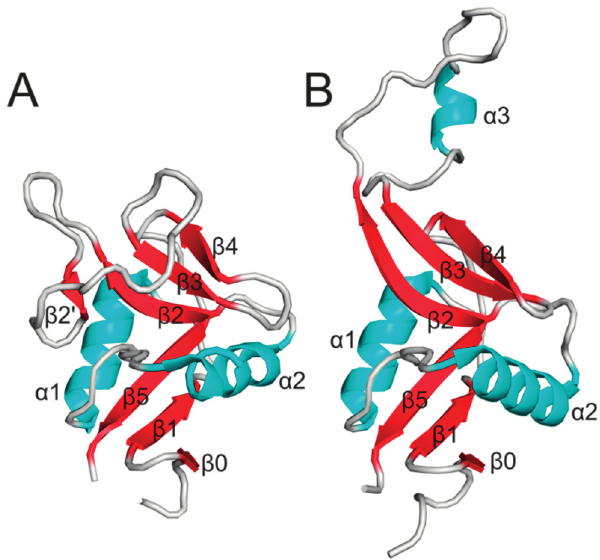
Figure 1. ( A ) Ribbon diagram of a typical CTLD. Secondary structure elements are labeled. α -helices are cyan, β -strands red and loops are gray; ( B ) Structure of the mouse Nkrp1a with a loop region pointing away from the central